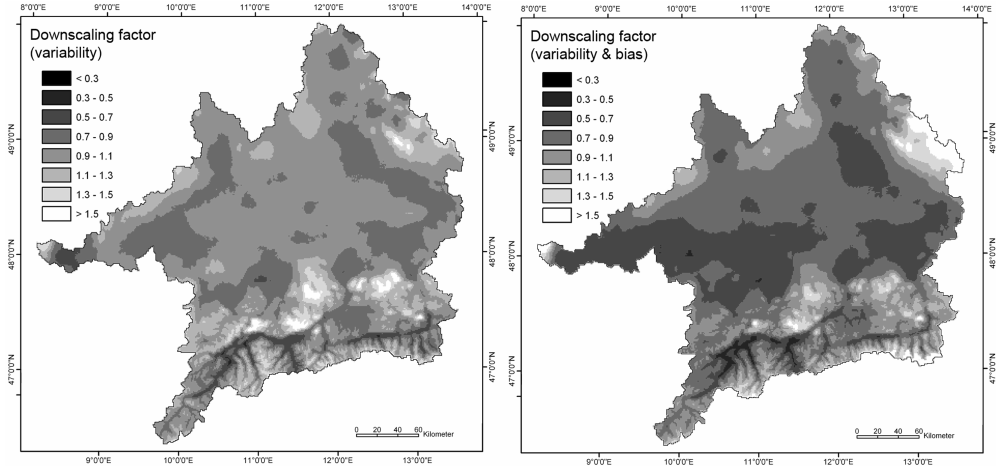
Fig. 5. Downscaling function for the correction for subgrid-scale variability (vari, 1 × 1km) in MM5-simulated precipitation (45 × 45km) for January (left) and function for a combined correction for subgrid-scale variability and bias (vari&bias) in MM5-simulated precipitation (ERA40 forcings) for January (right) as derived from meteorological observations and simulations for the period